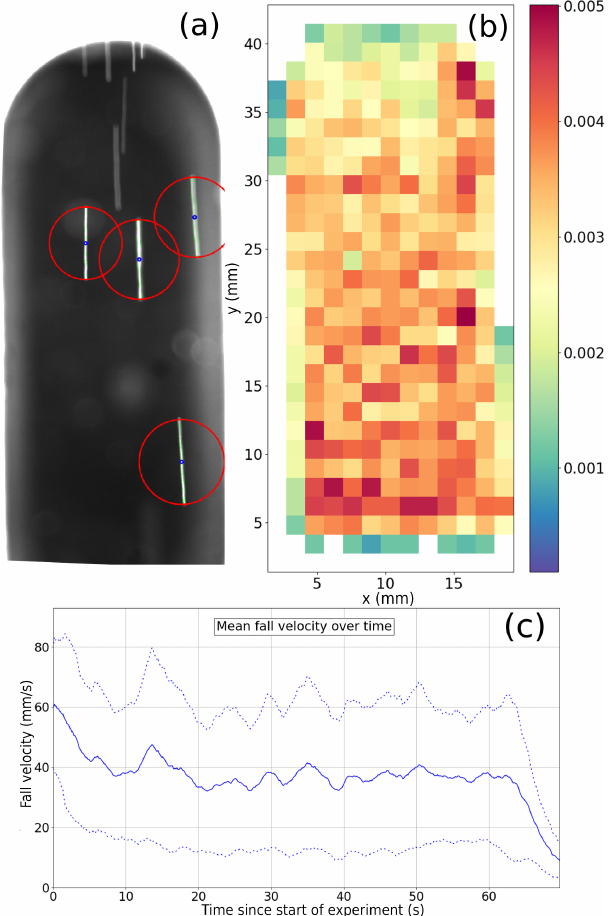
Figure 12. Distribution of different parameters for fall streak ex- periment: (a) crystal fall velocities extracted from streak images, (b) area-equivalent diameter ( D ae ) from microscope images of col- lected crystals, and (c) fall velocity predicted from D ae size distri- bution using Stokes theory (Eq.